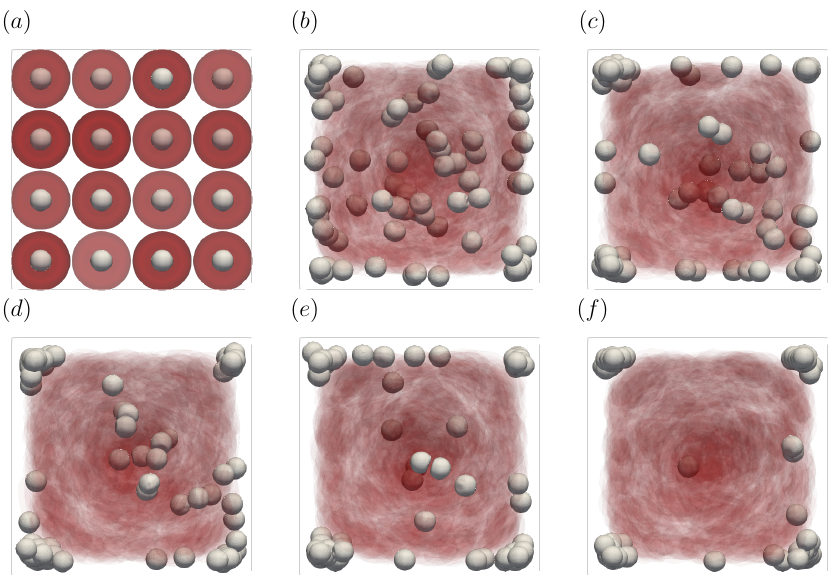
Figure 3. Snapshots of the simulation results in a straight channel of 224 × 32 × 32 µ m for ˙ γ w = 972 s − 1 , Ht = 20% at ( a ) t = 0, ( b ) t = 0.5, ( c ) t = 1.0, ( d ) t = 1.5, ( e ) t = 2.0, and ( f ) 3.0 s. The particles move gradually toward the corners of the